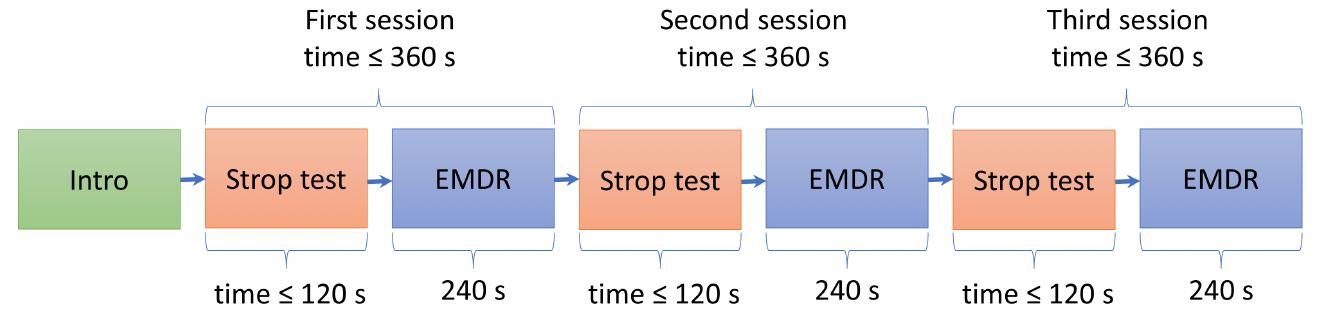
Figure 3. Timing protocol of the experiment. EMDR—Eye Movement Desensitization and Reprocessing.